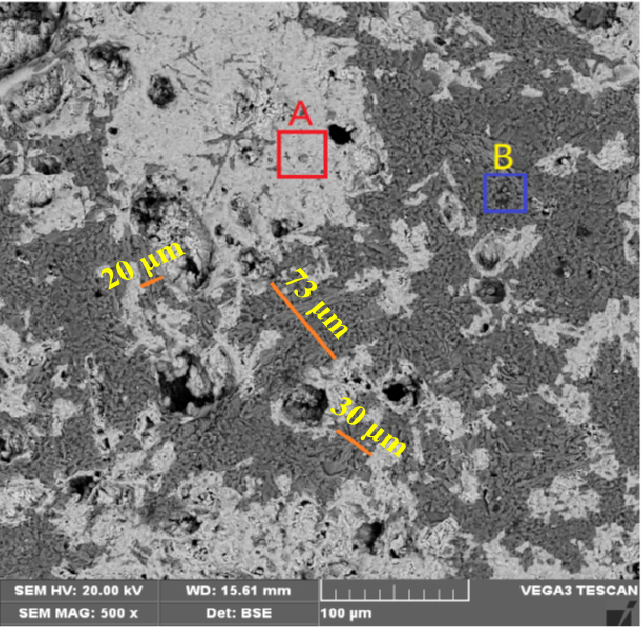
Figure 12. BSE image of the roasted ore. Table 5. EDS analysis of regions A and B (in Figure 12).